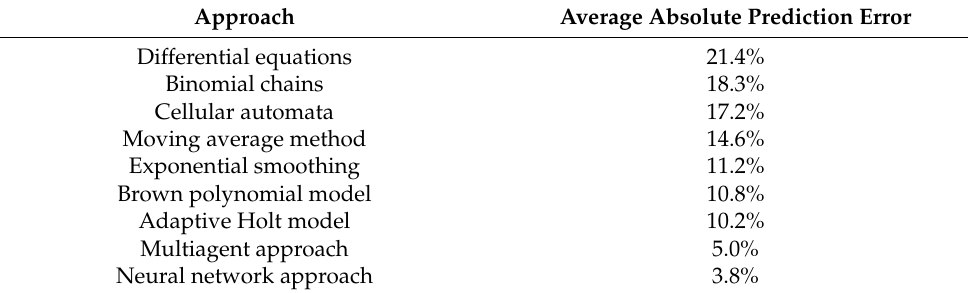
Table 1. Accuracy of the Lyme disease epidemic process models.